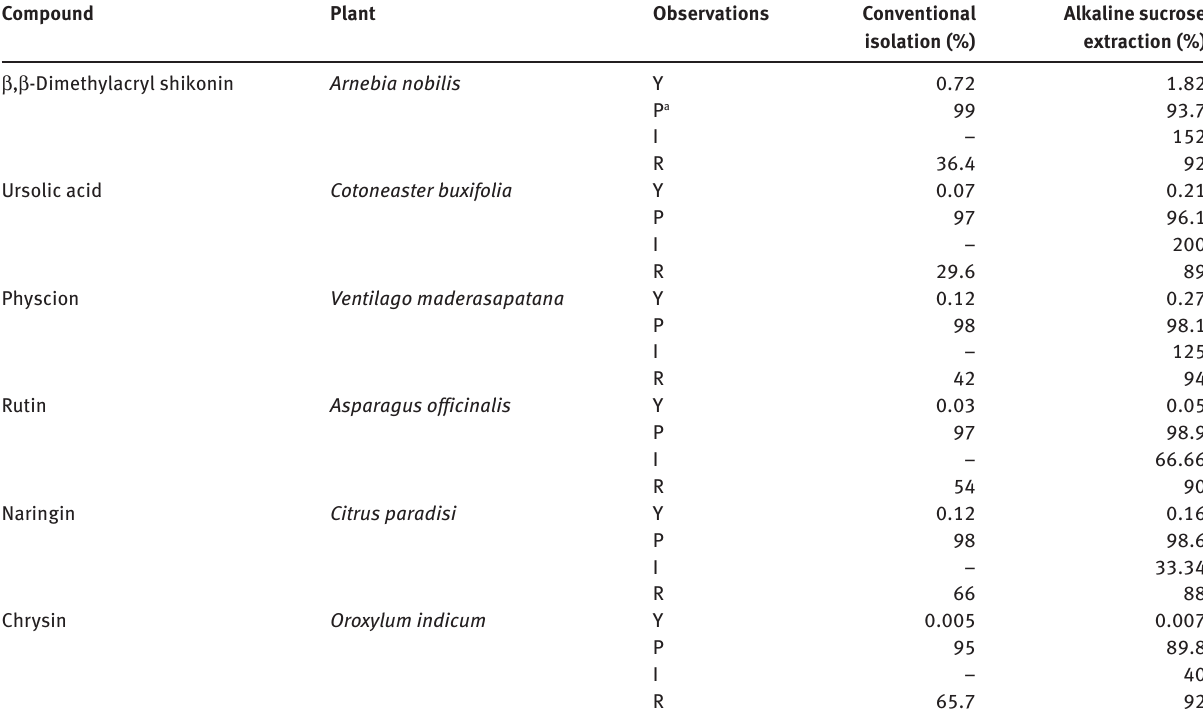
Table 6: Yield and purity of compounds from different methods.